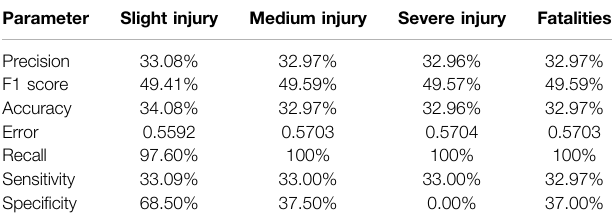
TABLE 1 | Percentages of parameters in the result of the decision tree.